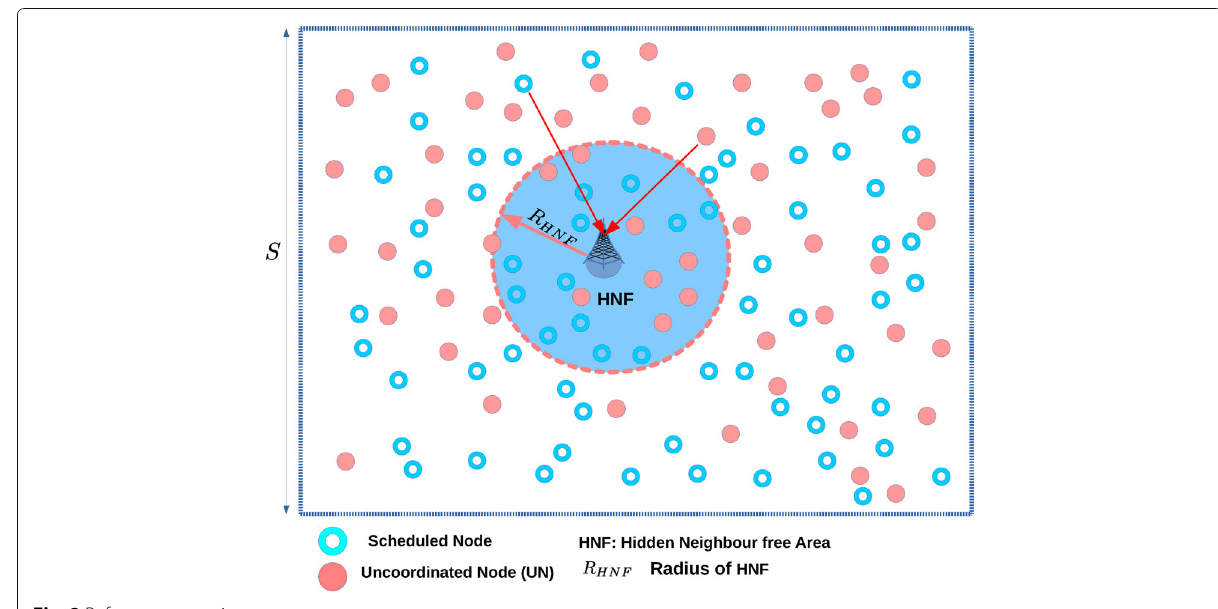
scheduling algorithm, N-PF; and (3) we consider here more different performance metrics, evaluating in details N-PF with different packet length adaptation schemes, and different system